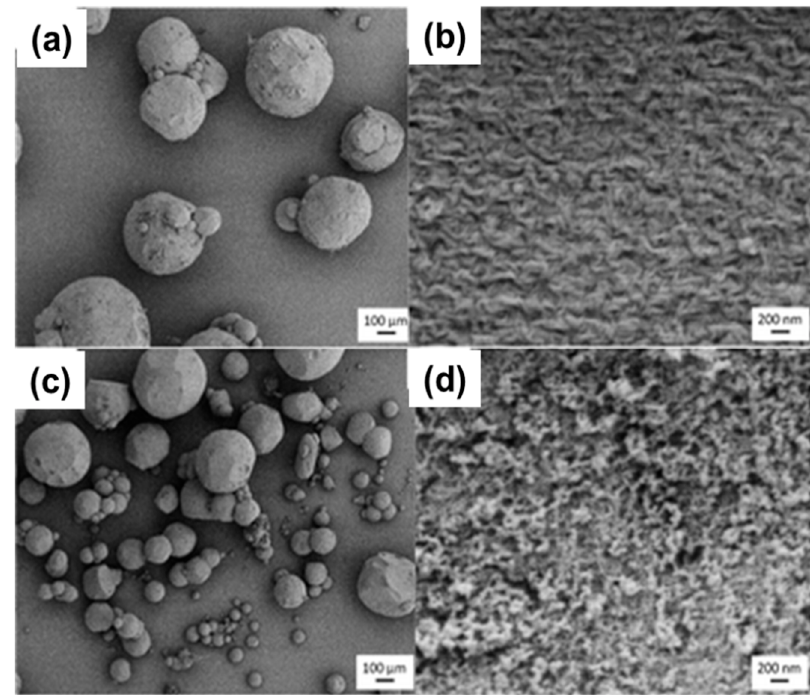
Figure 13. Pectin ( a , b ) and pectin-maghemite aerogel particles ( c , d ); reproduced with permission from reference [189].